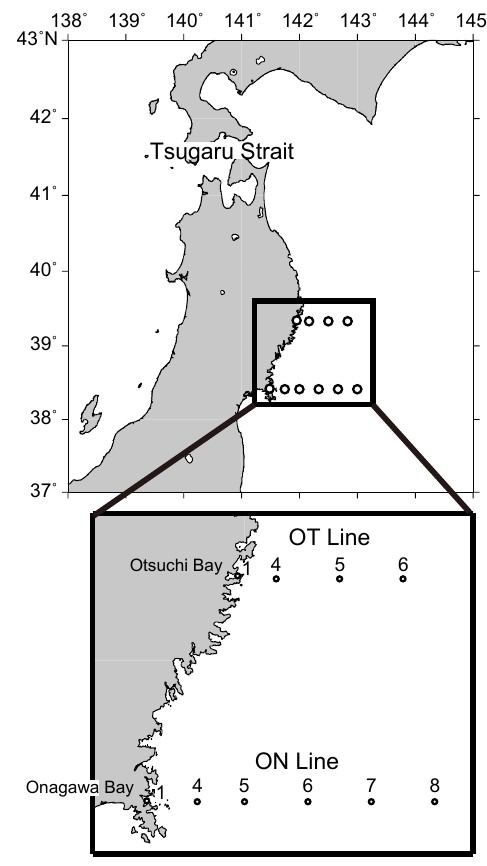
Figure 1. Sampling locations in the northwestern North Pacific